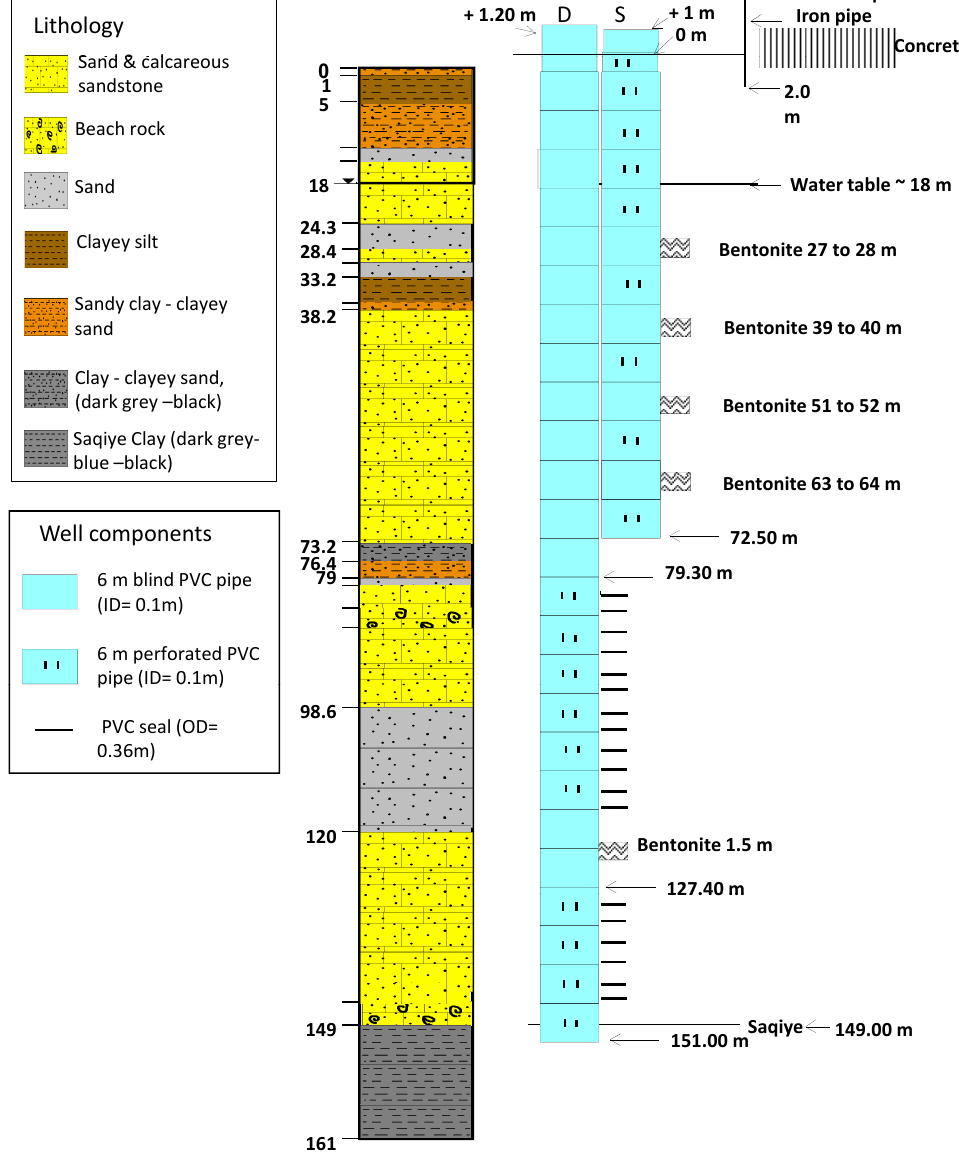
Fig. 2. Lithological log and perforation details of the observation well used for sequential multilevel sampling (MLS). D – pipe perforated against the deep subaquifer (79–149m); S – pipe perforated against the shallow subaquifer (18–72m); all depths are relative to ground